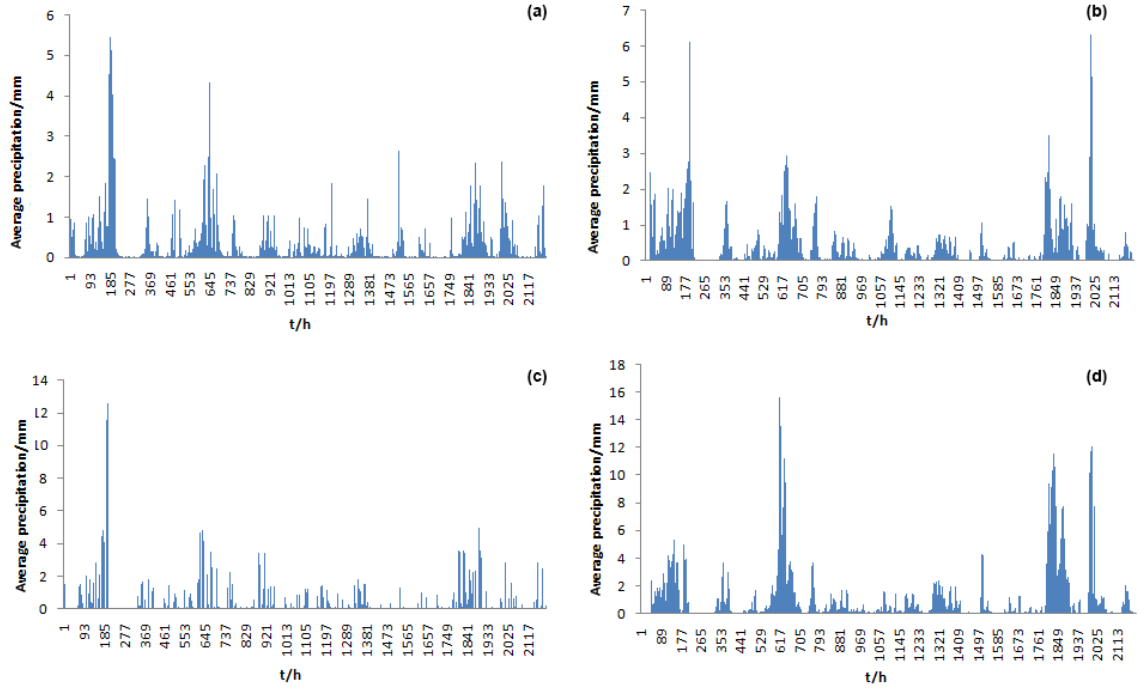
Figure 4. Precipitation pattern comparison of two precipitation products (2013). (a) is the average precipitation of rain gauges, (b) is the average precipitation of WRF with 24h lead time, (c) is the average precipitation of WRF with 48h lead time, and (d) is the average precipitation of WRF with 72h lead